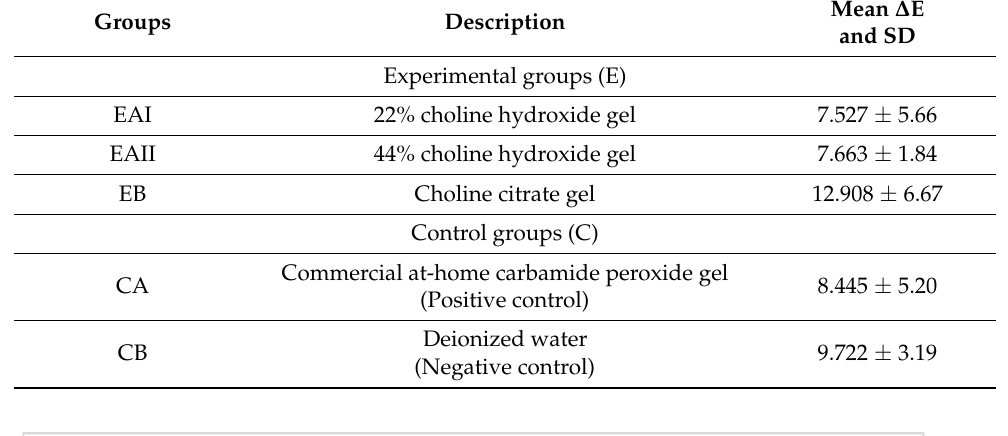
Table 3. Mean ∆ E values of the tooth samples.